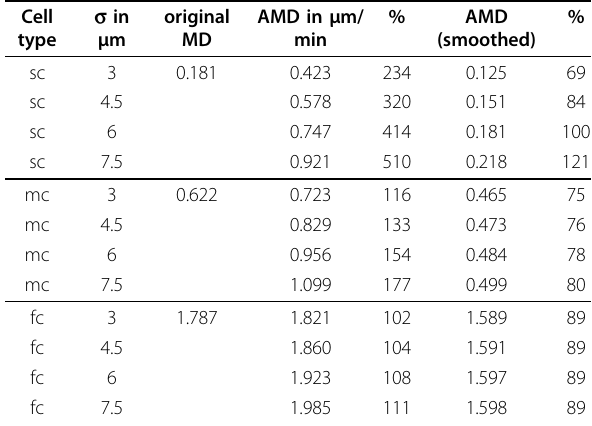
Table 1 Cell speed variability caused by imprecise centroid